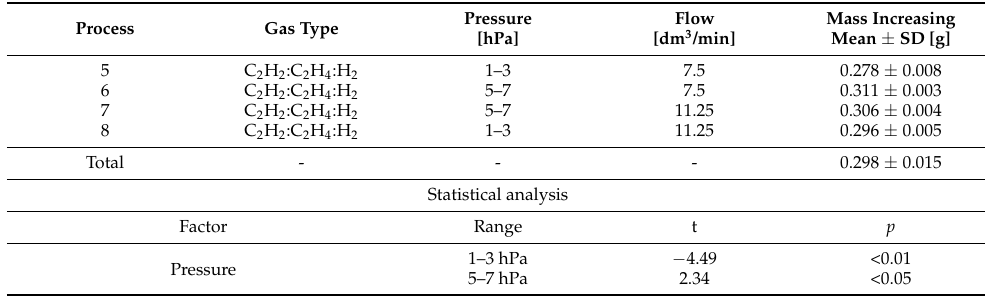
Table 3. The mass of carbon introduced into the surface layer in low-pressure carburisation